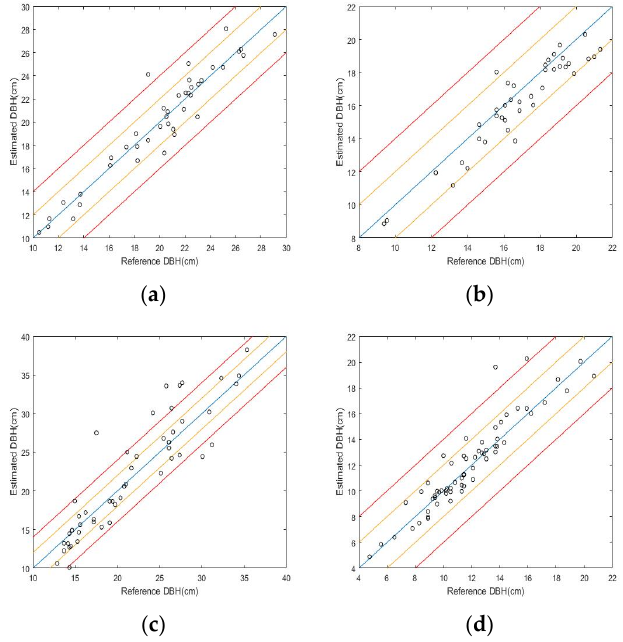
Figure 10. SfM estimates in relation to the reference value. The horizontal and vertical coordinates of a point are the estimated value and the reference value of the DBH of a tree. The blue, orange, and red lines are the 0, 2, and 4 cm errors bound for estimated DBH. ( a ) Plot 1 (Beijing); ( b ) Plot 2 (Yinan); ( c ) Plot 3 (Beijing); ( d ) Plot 4 (Beijing). Table 3. The accuracy of SfM DBH estimates with respect to the reference value.